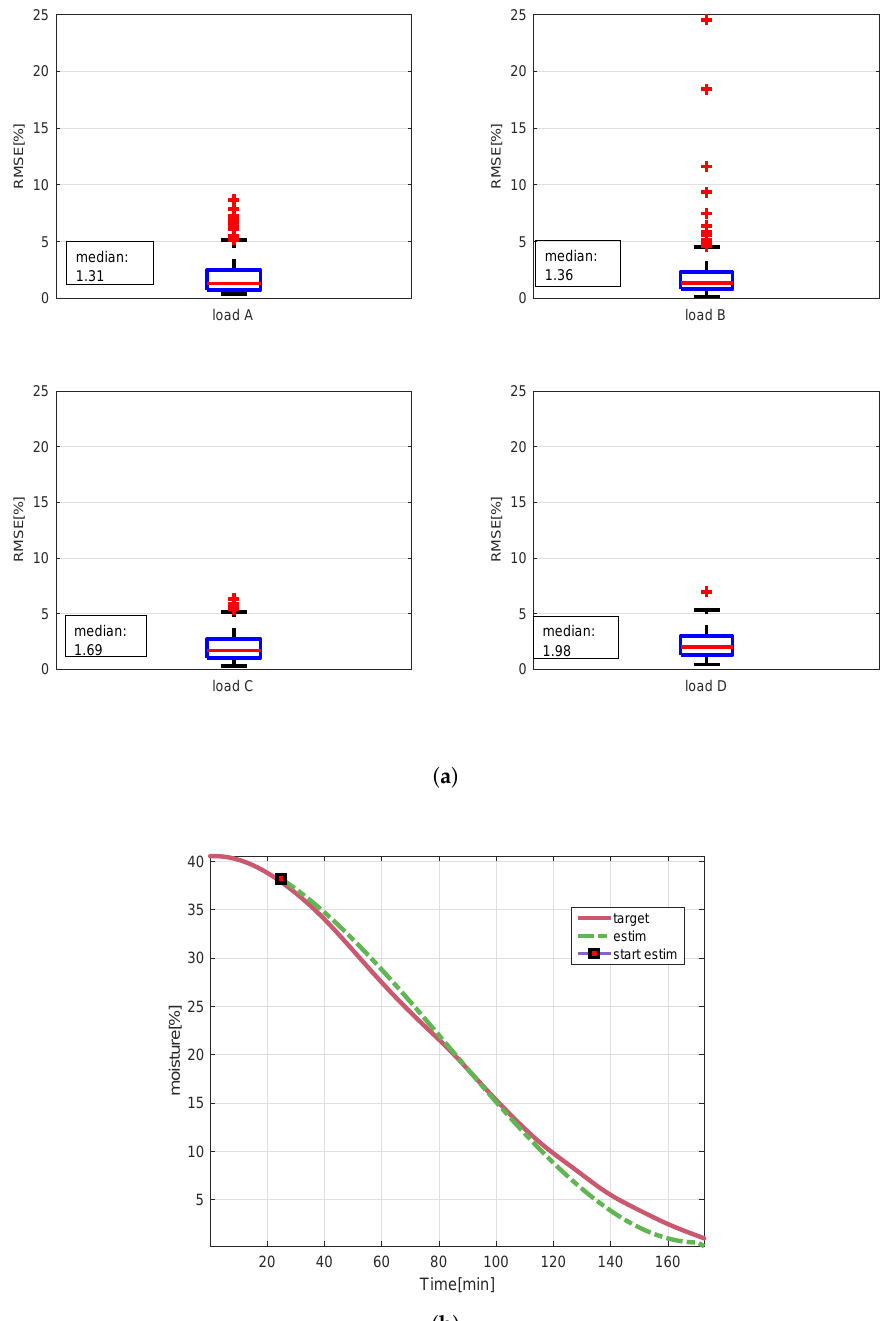
Figure 10. Examples of results using Method 3: ( a ) Current performance in terms of RMSE distribution (in % moisture content) using Method 3. The results divided by laundry nominal load are listed with increasing size of input signals from left to right. ( b ) An example of laundry moisture content estimation using the 3 rd -degree polynomial model in time, on y-axis the moisture content in percentage (the square represents the time in which the estimation is provided during drying